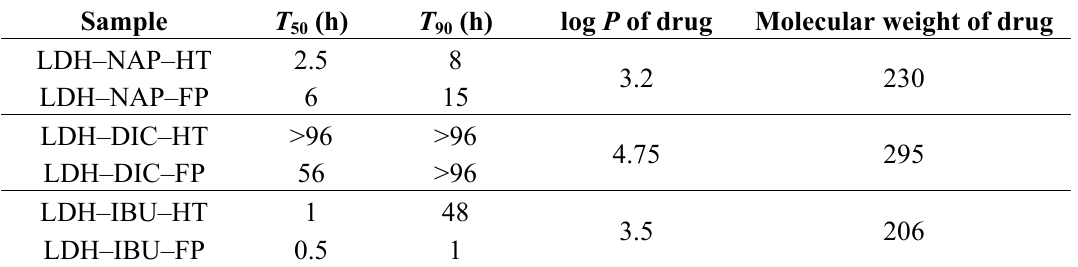
Table 4. Key parameters in LDH–drug release. T 50% and 90% of drugs from LDH–drug. The lipophilicity (log P ) and molecular weight of drugs are also listed